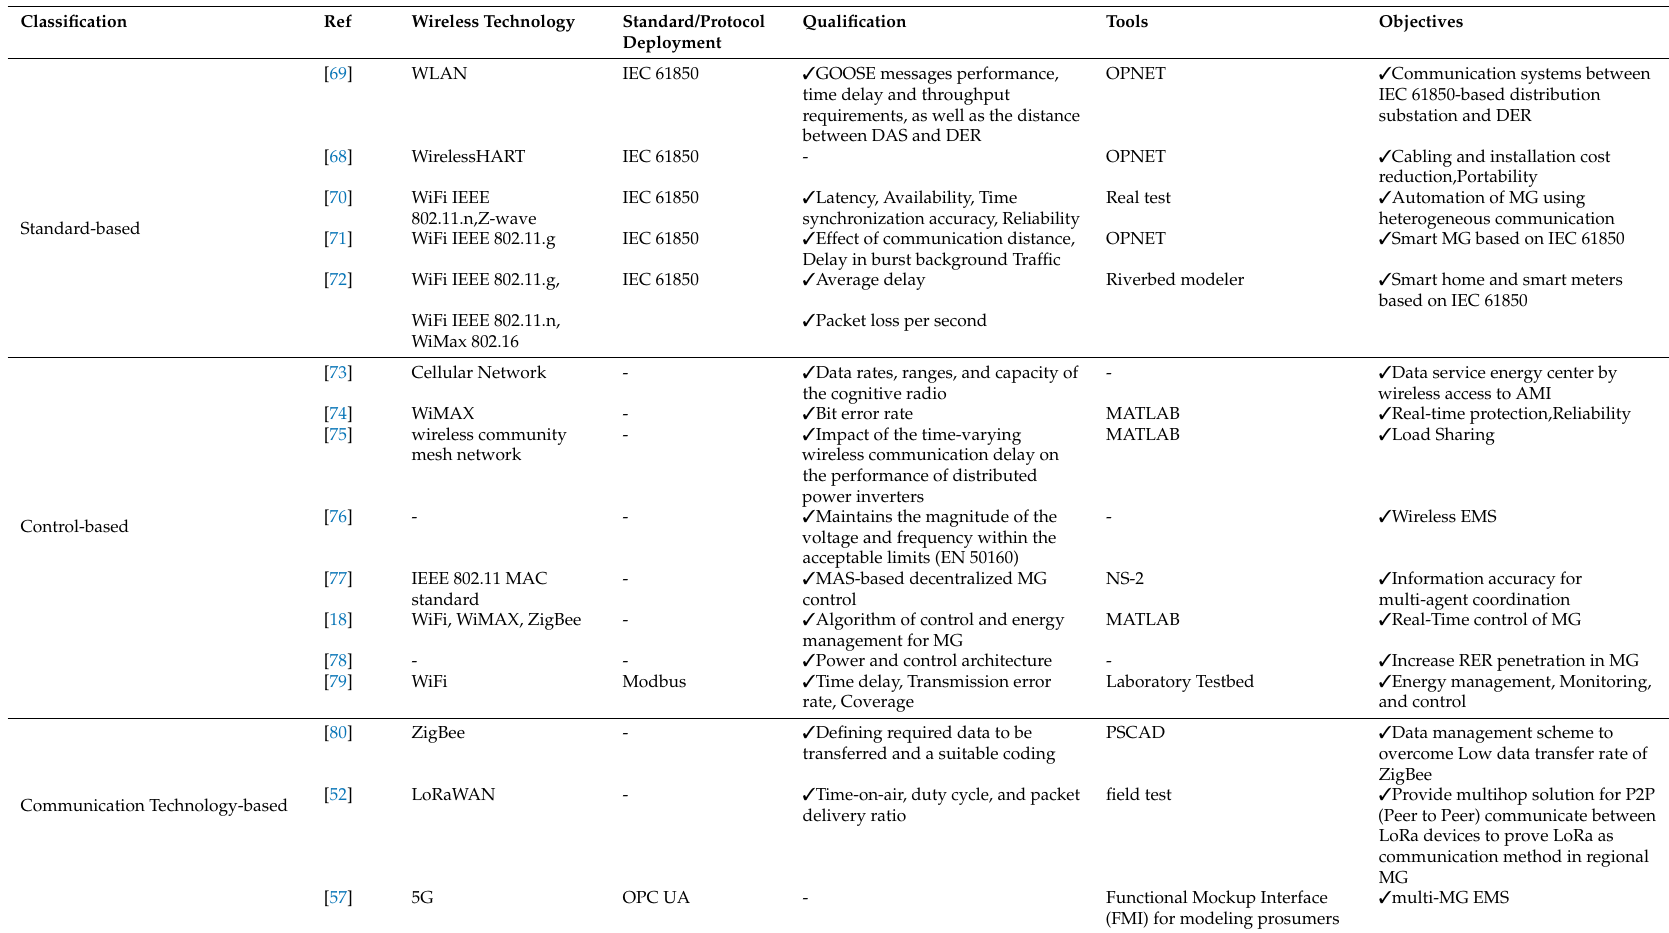
Table 6. Classification of wireless-based MG